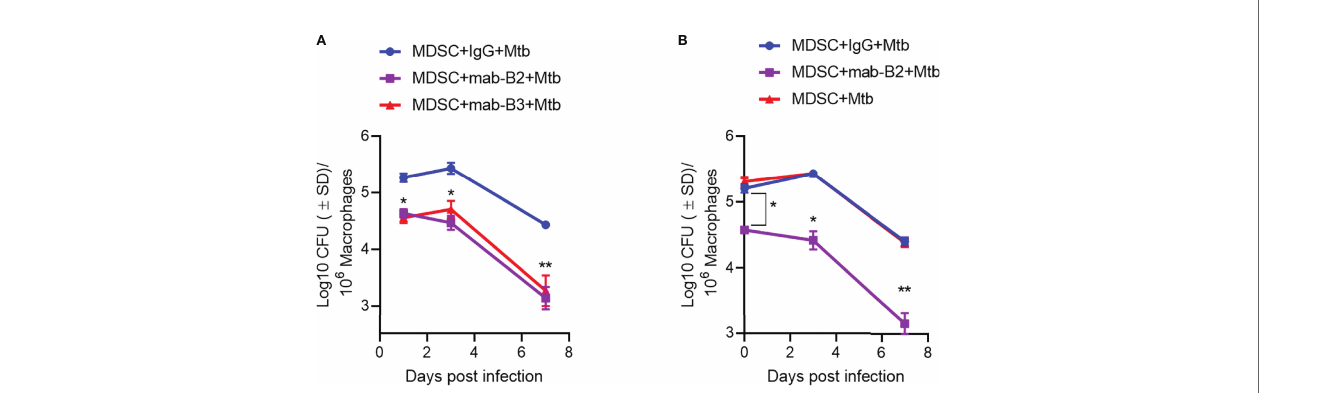
FIGURE 4 | Prior treatment of MDSCs with monoclonal antibodies to leukocyte immunoglobulin-like receptors B2 and B3 (LILRB2/3) enhances their bactericidal function against Mtb. ( A, B ) CD33 + fl ow sorted MDSCs from donor PBMCs (A) or CD14 + /CD33 + bead-puri fi ed M-MDSCs derived from GM-CSF/IL-6 cultured PBMCs from donors (B) were activated or not with monoclonal antagonist antibodies to LILRB2 (mab-B2) or LILRB3 (mab-B3) followed by infection with Mtb H37Rv (MOI = 1) and incubation over time. Lysates were plated at indicated time points for Mtb CFUs on 7H11 agar (*, ** p < 0.007 1-way ANOVA and Tukey ’ s posttest; 1 of 2 similar experiments